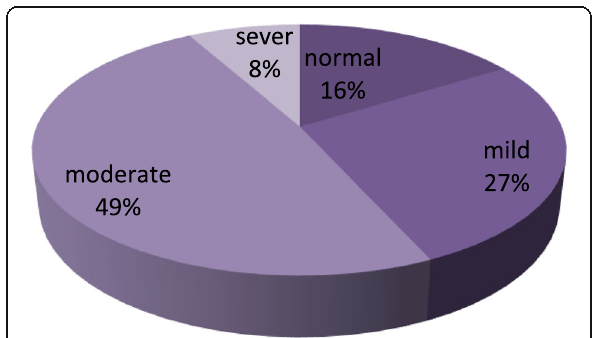
Fig. 5 Percentage of patients according to the degree of right ventricular dilatation by MRI